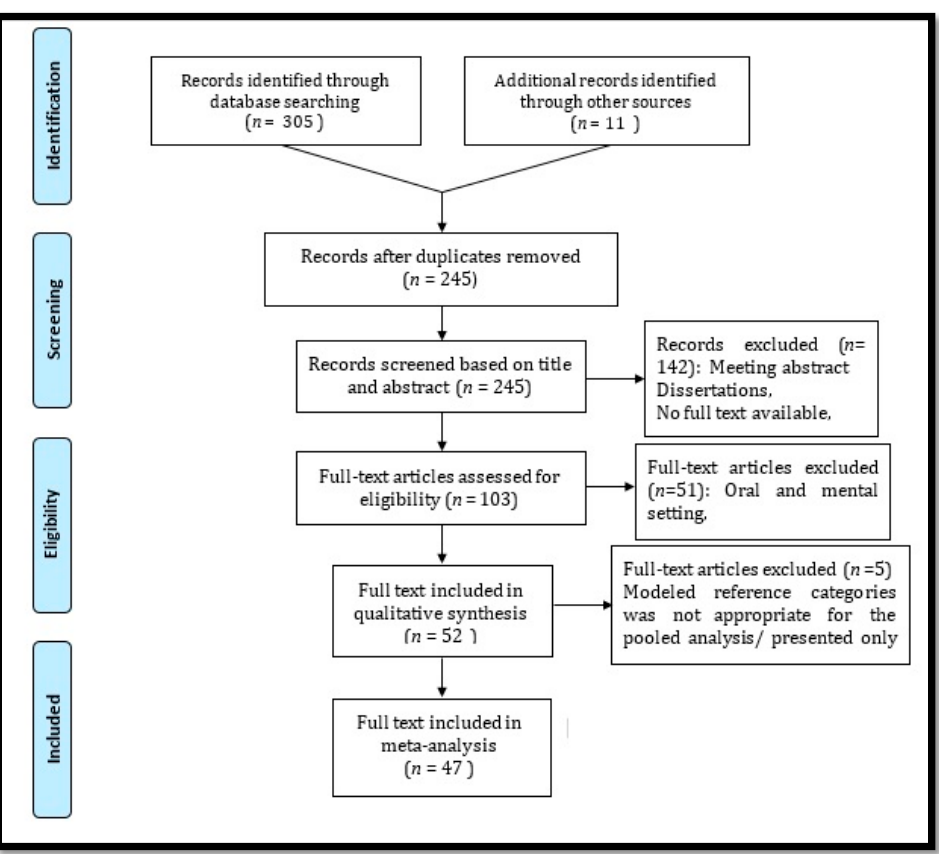
Figure 1. PRISMA flow diagram.